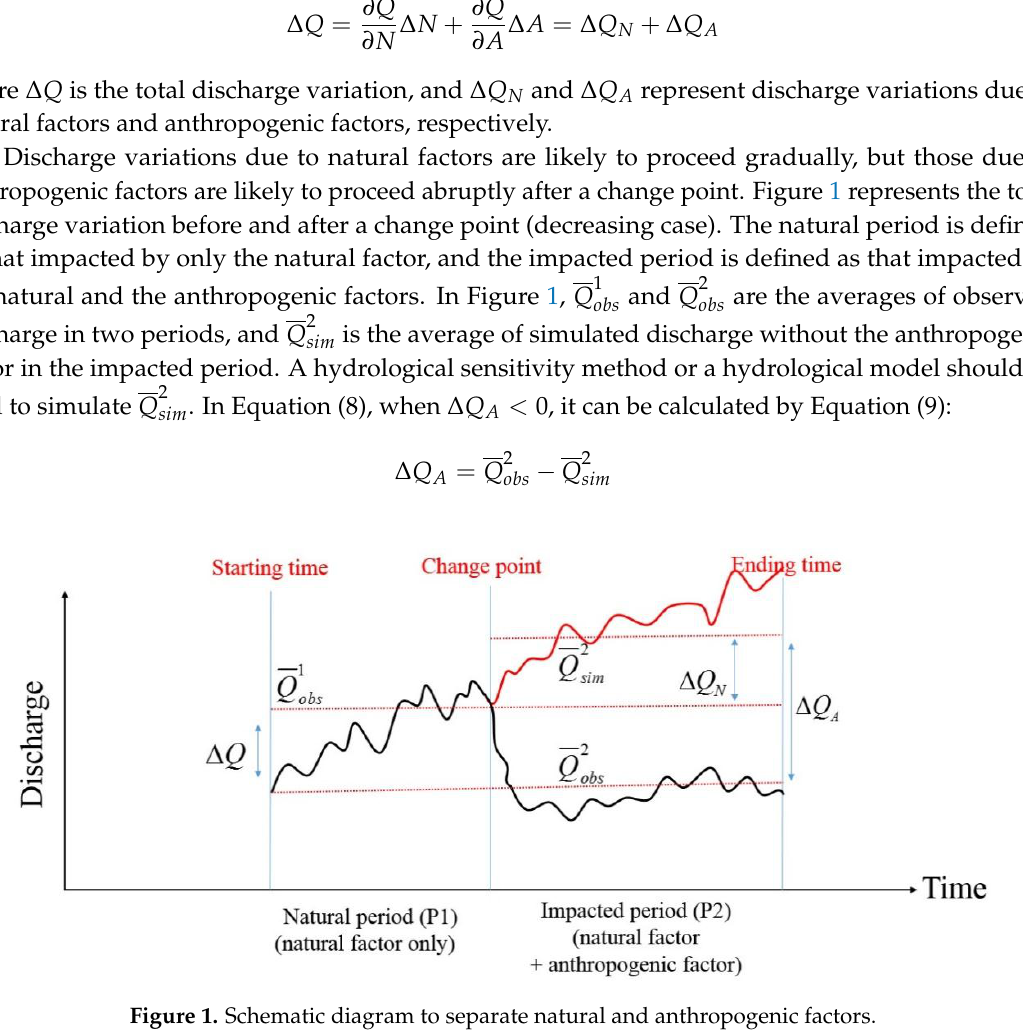
Figure 1. Schematic diagram to separate natural and anthropogenic factors.